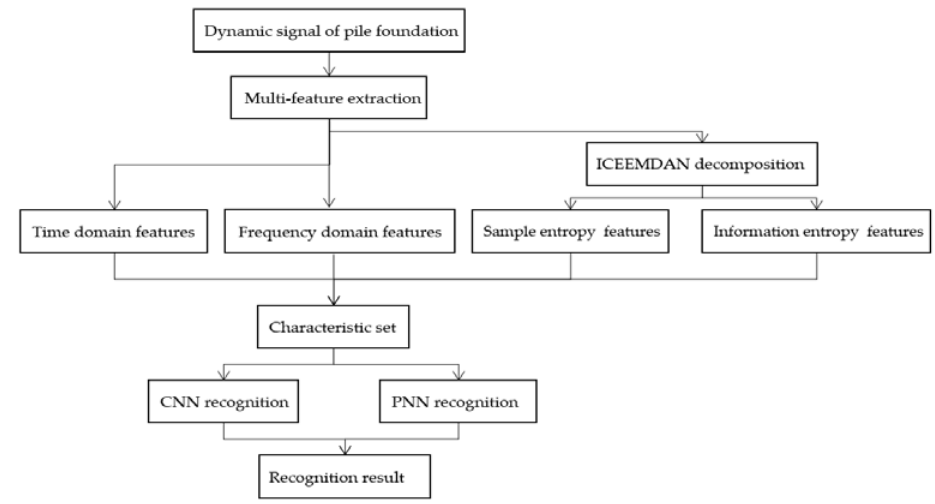
Figure 13. Recognition model.